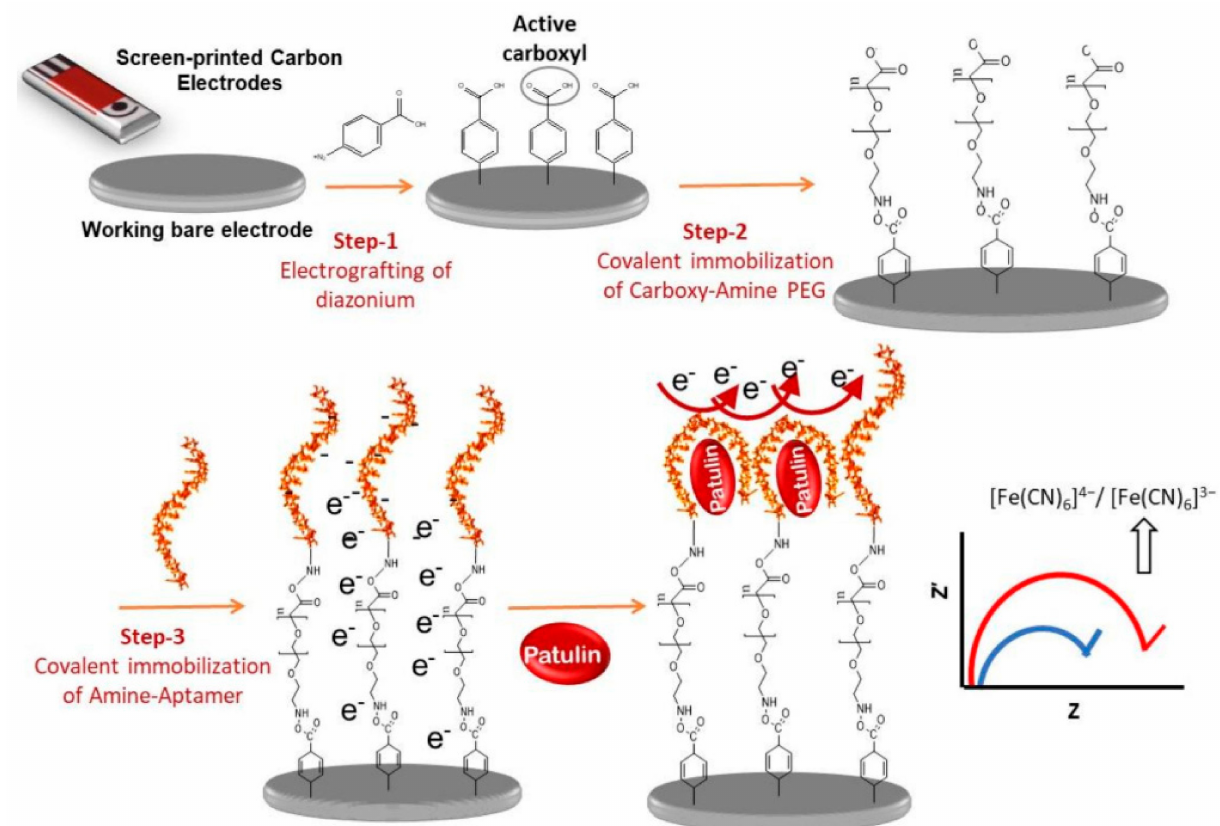
Figure 8. Design and working principle of an impedimetric aptasensor for patulin employing a detection platform obtained via diazonium electrografting. Reprinted from